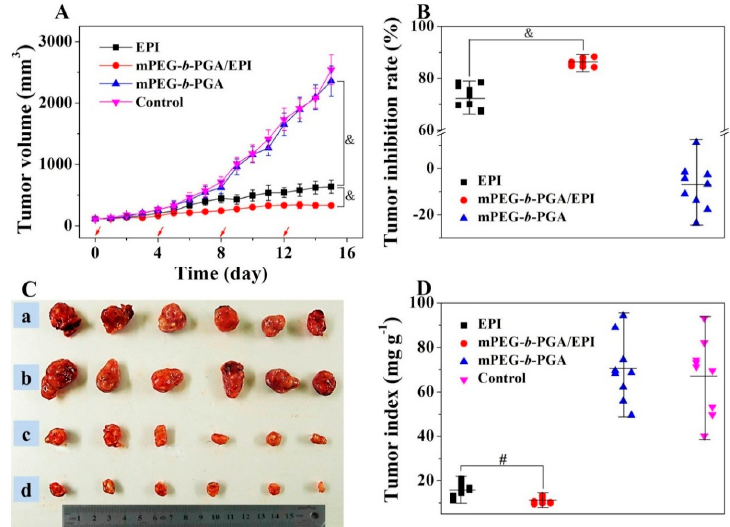
Figure 10. Tumor volumes ( A ), tumor inhibitory rates ( B ), tumor macroscopical images ( C ), and tumor indices ( D ) of H22 HCC-xenografted mice after treatment with free EPI, mPEG- b -PGA/EPI, or mPEG- b -PGA with NS as control. The red arrows in (A) meant the treatment times. Tumors in a, b, c, and d of ( C ) were from control, mPEG- b -PGA, free EPI, and mPEG- b -PGA/EPI groups, respectively. Data were presented as mean ± SD ( n = 10; # p < 0.01, & p < 0.001).